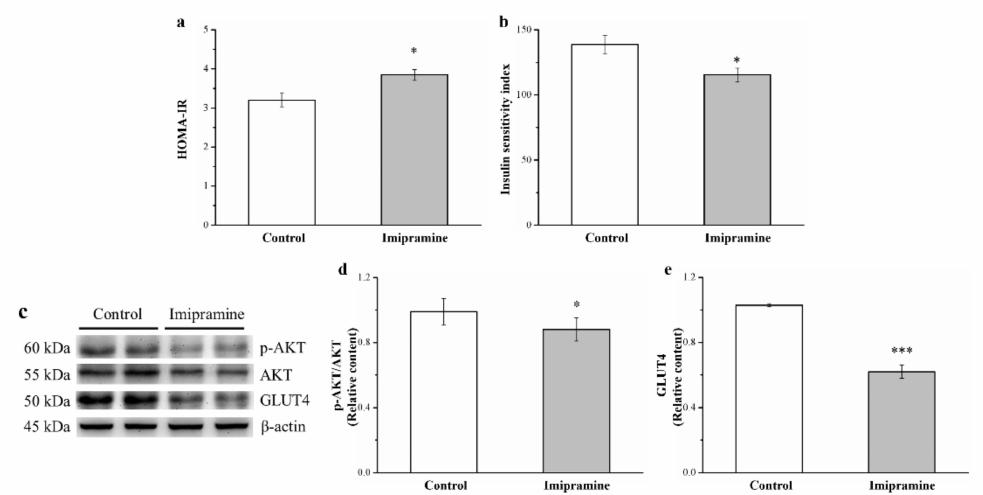
Figure 7. Effects of imipramine on the ( a ) homeostasis model assessment-estimated IR (HOMA-IR) index and ( b ) insulin sensitivity (IS) index. ( c ) Representative blot of gastrocnemius muscle extracts. Expression levels of ( d ) phosphorylated Akt and ( e ) GLUT4. Data are in the form of mean ± standard deviation ( n = 8). * p < 0.05; *** p < 0.001.